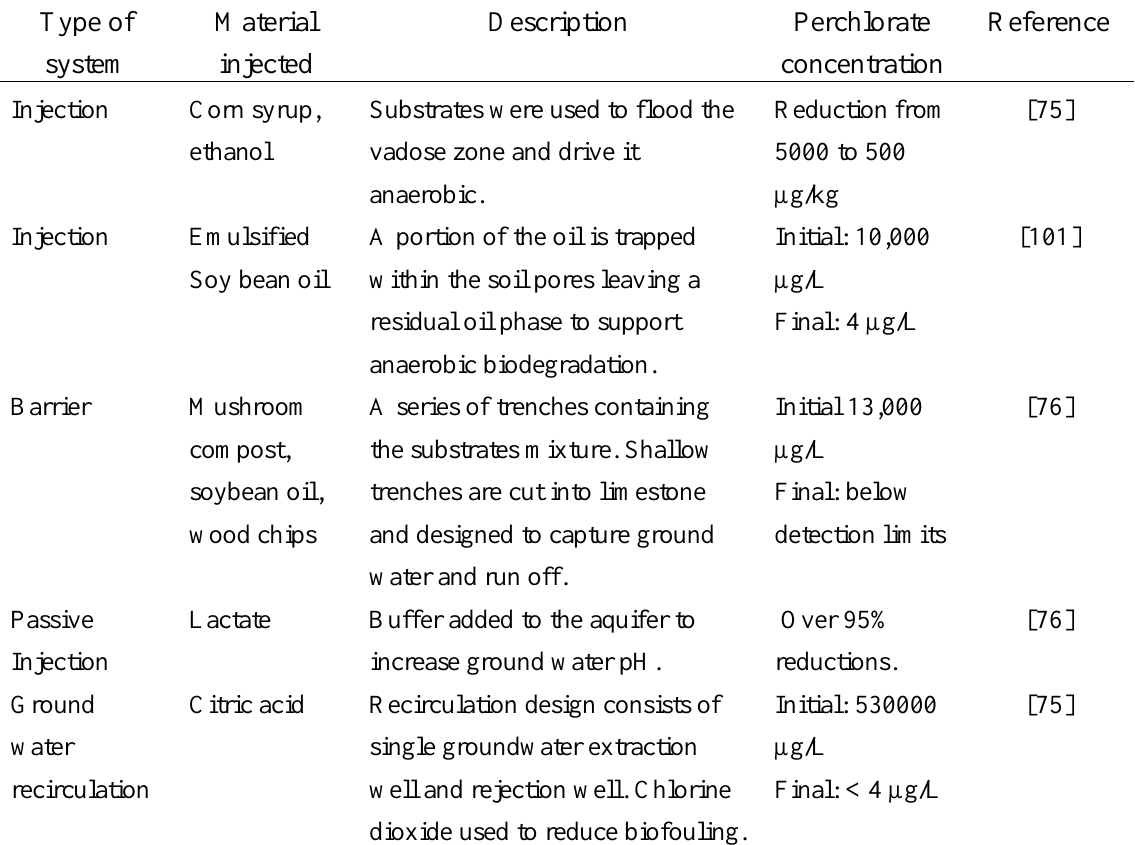
Table 7. Summary of in situ bioremediation for treating